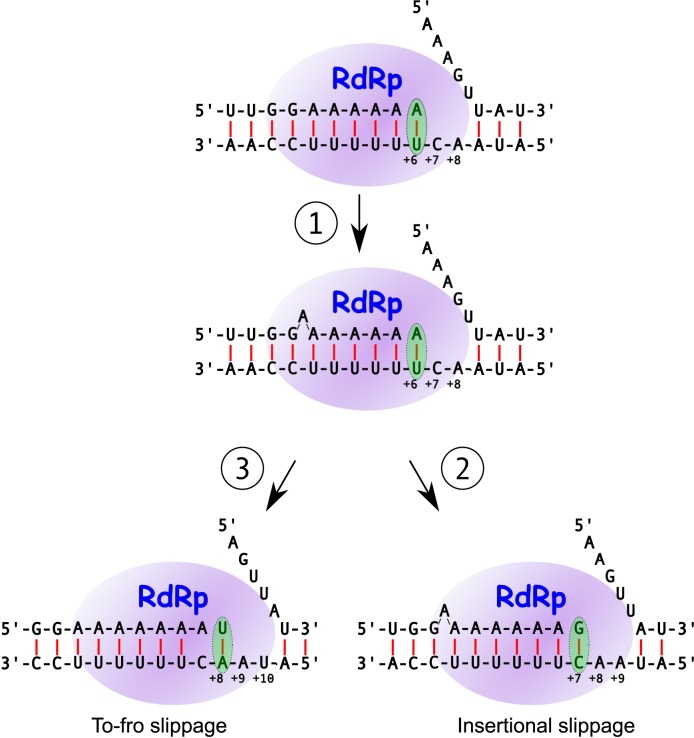
Cartoon model of insertional and to-fro slippage. At each step the polymerase is illustrated in a post-binding pre-incorporation stage. Green ellipses highlight the nucleotide entry and recognition site. Phosphodiester bonds and Watson–Crick base-pairings are indicated in black and red, respectively. (1) Following incorporation of the A templated by the +6 position, the nascent strand AAAAAA slips back 1 nt relative to the polymerase/template, resulting in a bulge nucleotide and freeing the last U of template-strand UUUUUU to template an additional A (middle). This might involve the nascent RNA slipping independently in the pre-translocation polymerase, or the polymerase and nascent RNA slipping together after translocation. Following incorporation and translocation, either (2) polymerization continues in the newly acquired register with binding of G templated by the +7 position (insertional slippage; bottom right) or (3) the nascent strand AAAAAAA slips forward 1 nt, without incorporation a second translocation occurs (possibly driven by relief of the nucleotide bulge) with A:C mispairing in the active site, and polymerization continues in the original register with binding of U templated by the +8 position (to-fro slippage; bottom left).